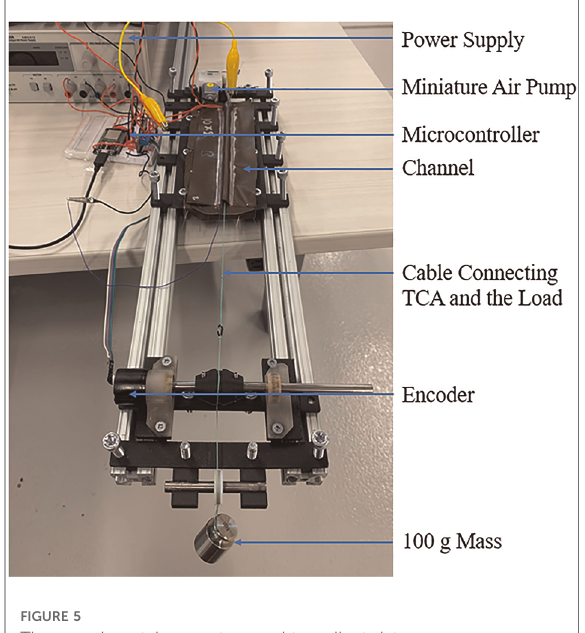
FIGURE 5 The experimental apparatus used to collect